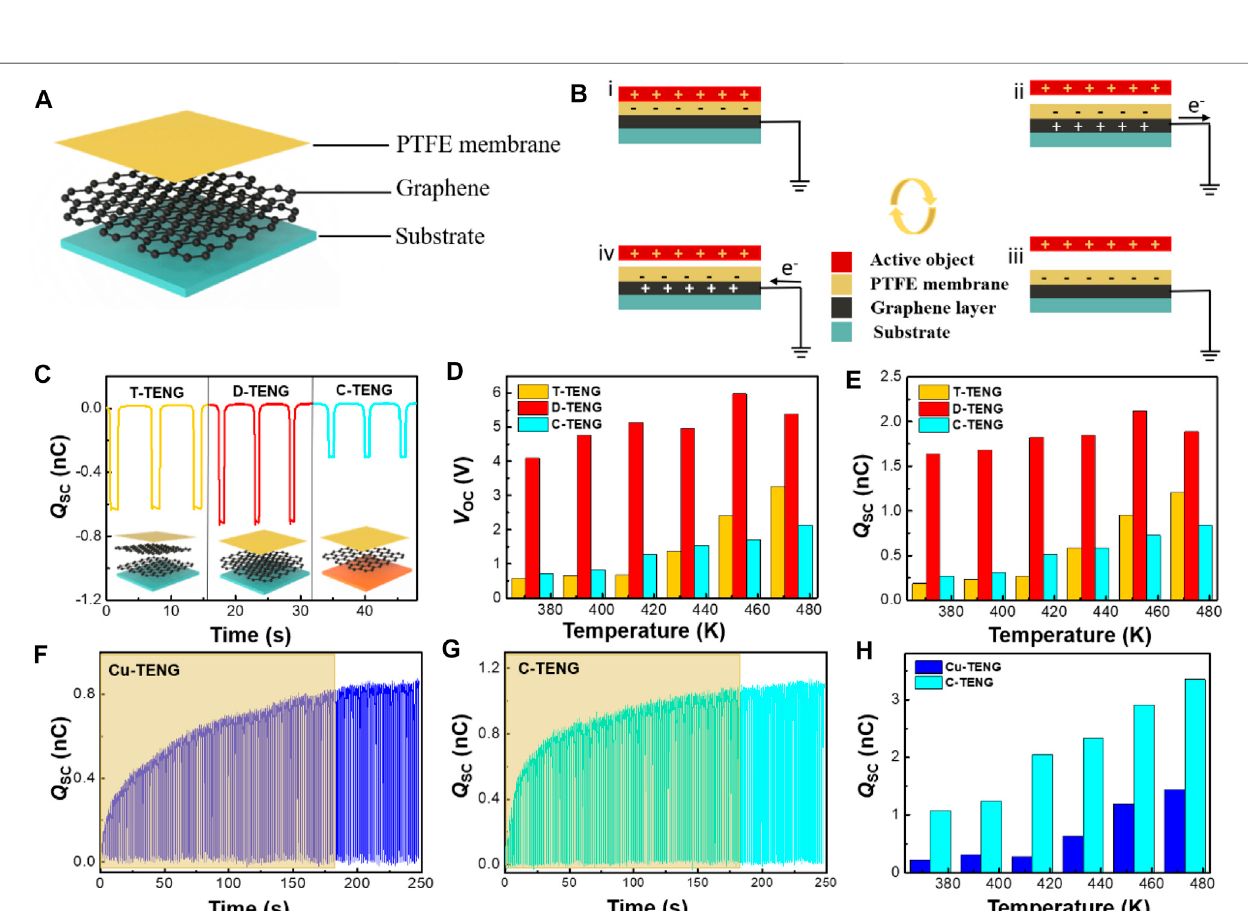
FIGURE 7 | Principles and output tests of three different TENGs. (A) Schematic diagrams showing the working principle of the TENG. (B) Contact electri fi cation mechanismofTENGs. (C) Q sc oftheCu-TENG andC-TENG atroom temperature. (D,E) Histograms of V oc , I sc ,and Q sc measured during thetemperature risefrom373 to 473 K for the T-TENG, D-TENG, and C-TENG in a 1 cm × 1 cm area. (F,G) are the transferred charges of the C-TENG and Cu-TENG under the same conditions, respectively. (H) Histograms of Q sc for the C-TENG and Cu-TENG from 373 to 473 K with an area of 2 cm × 2 cm.